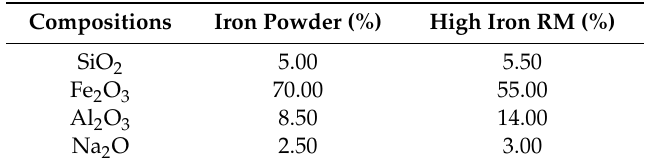
Table 7. Compositions of iron powder and high iron RM from Bayer RM.